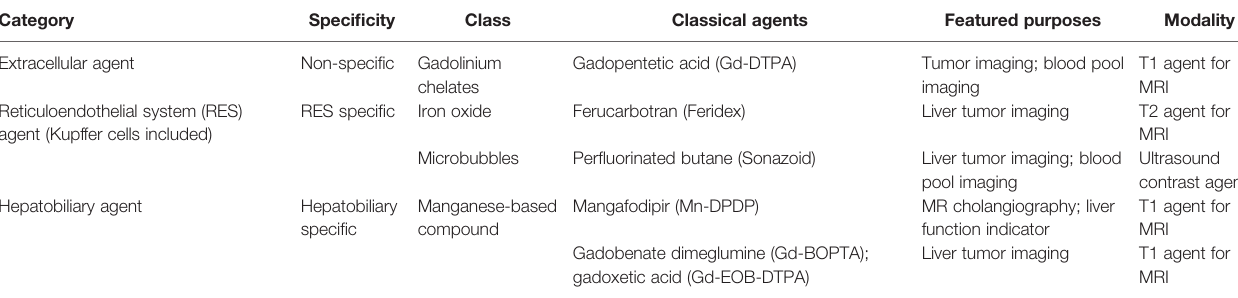
TABLE 1 | The categories of extracellular contrast agents in clinical